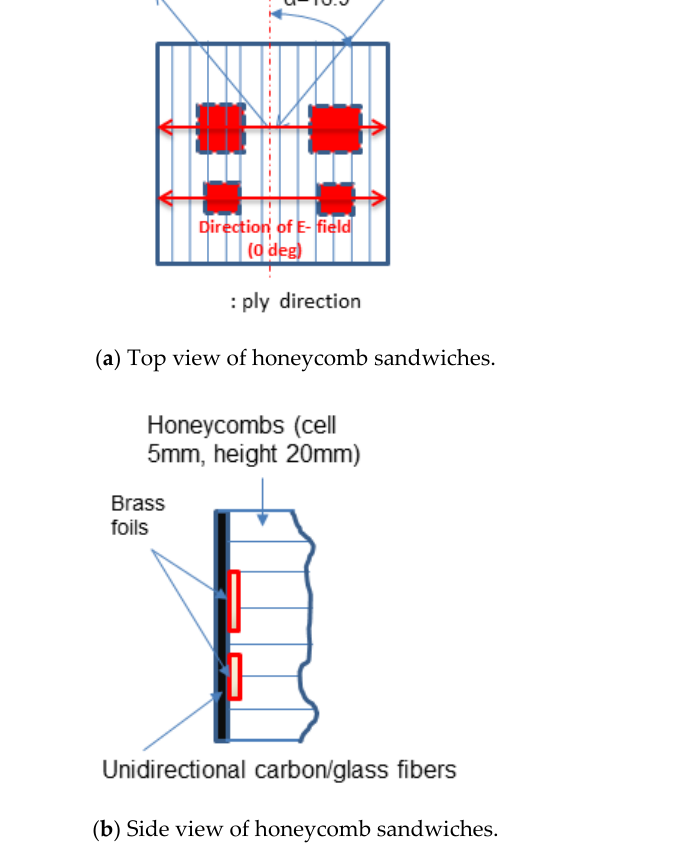
Figure 7. Overview of T-ray reflection mode on honeycomb sandwich panels.